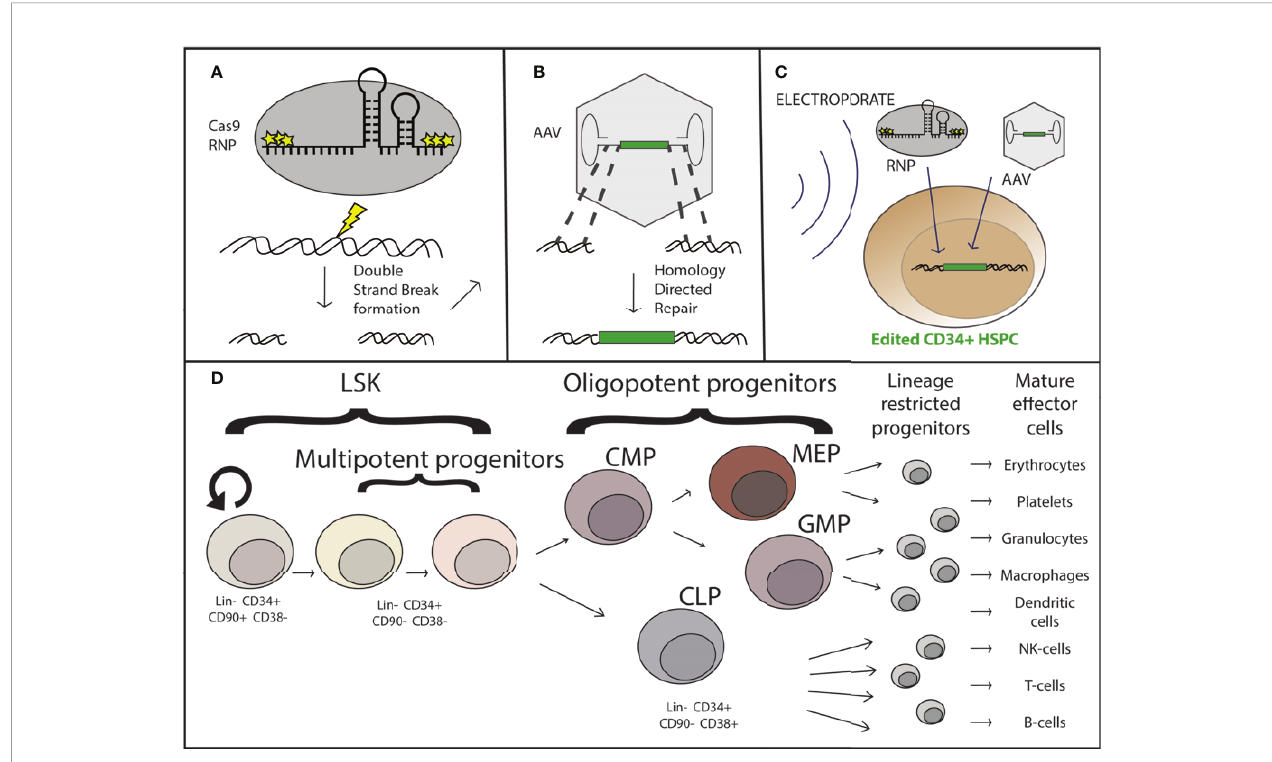
FIGURE 1 | Overview of AAV-based hematopoietic stem and progenitor cell gene editing. Puri fi ed Cas9 protein complexed with chemically modi fi ed guide RNA as a ribo-nucleoprotein complex (RNP) induces a double strand break at a speci fi c locus (A) , at which site fl anking regions of homology within the recombinant AAV genome serve as templates for homology directed repair and incorporation of the corrective sequence [green] after DNA delivery by the AAV vector (B) . The genome editing components are delivered simultaneously ex-vivo via nucleofection the CD34+ hematopoietic stem and progenitor cells which have been stimulated to enter the cell cycle through treatment with a cytokine cocktail including SCF, TPO, Ftl3, and IL-6 (C) . The CD34+ subset of cells is comprised of both long term hematopoietic stem cells (LT-HSCs) which can self-renew and maintain full differentiation potential to reconstitute the entire hematopoietic system, as well as multipotent and oligopotent progenitors which have limited or no self-renewal capacity and are lineage restricted (D)